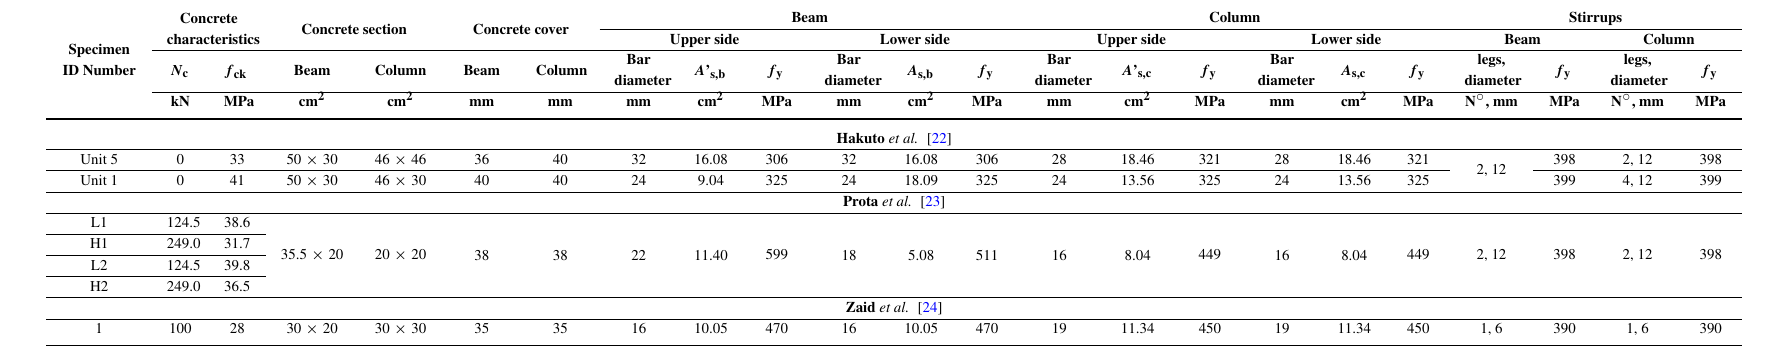
Table 4. Geometrical and mechanical properties of specimens of experimental